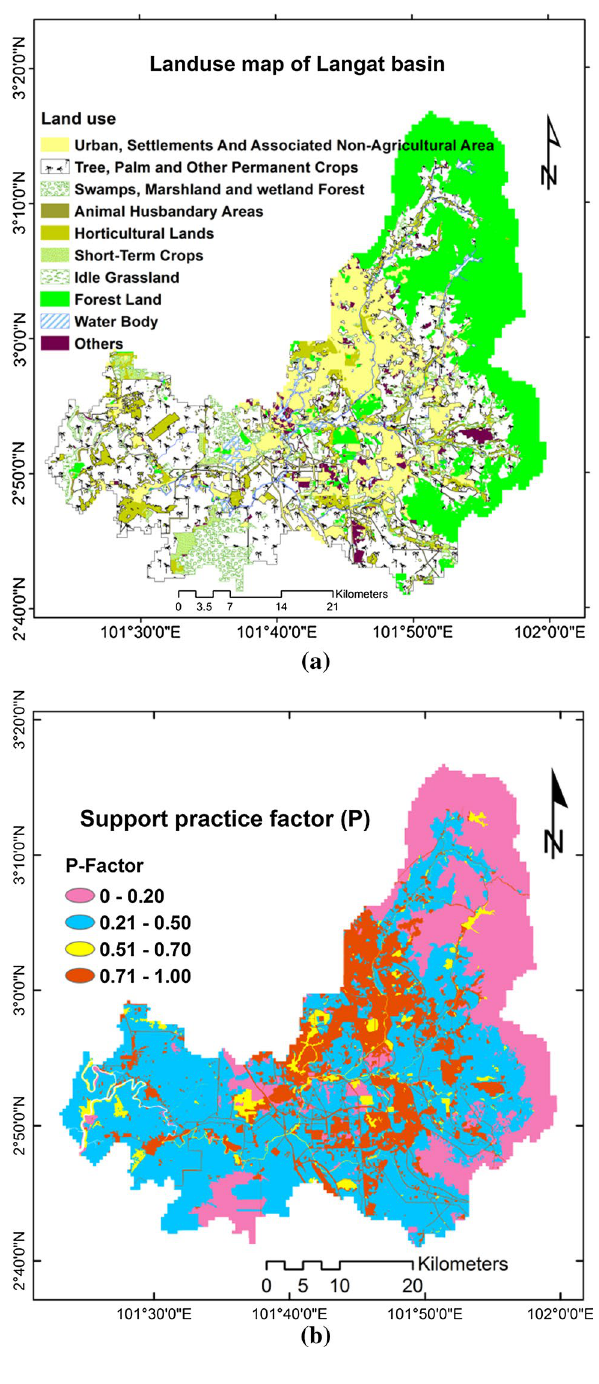
Fig. 8 Land use map ( a ) and support practice factor (P) map ( b ) of the study area